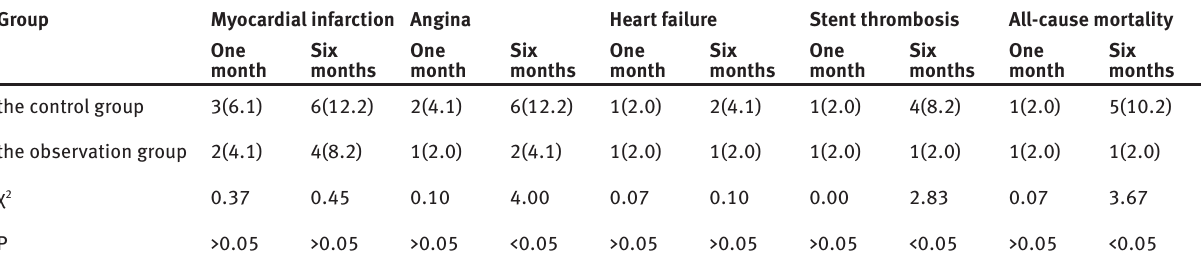
Table 4: Comparison of MACE Incidence after PCI between two groups [case%]